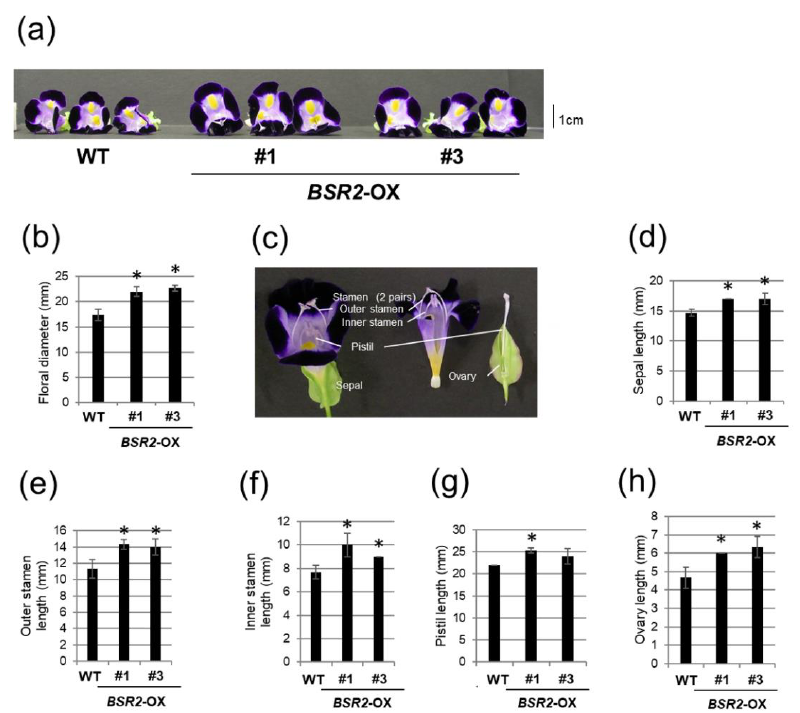
Figure 4. Comparison of floral morphology between WT and BSR2 -OX torenia. Comparison of ( a ) flowers and ( b ) floral diameter between WT and BSR2 -OX lines 6 days after flowering. ( c ) Schematic representation of torenia flower. Comparison of longitudinal lengths of ( d ) sepals, ( e ) outer stamens, ( f ) inner stamens, ( g ) pistils, and ( h ) ovaries 6 days after flowering. Error bars represent standard deviation ( n = 3). * values significantly different from WT (* p < 0.05; Dunnett’s tests).